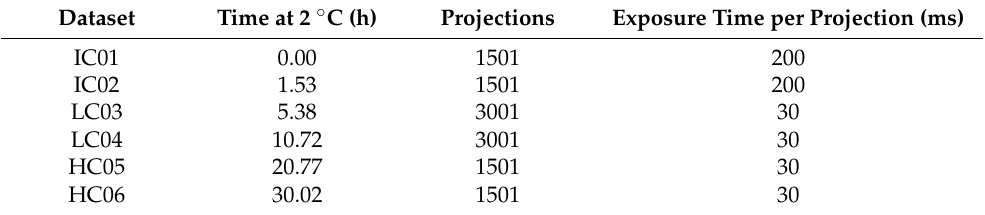
Table 1. SXCT scan